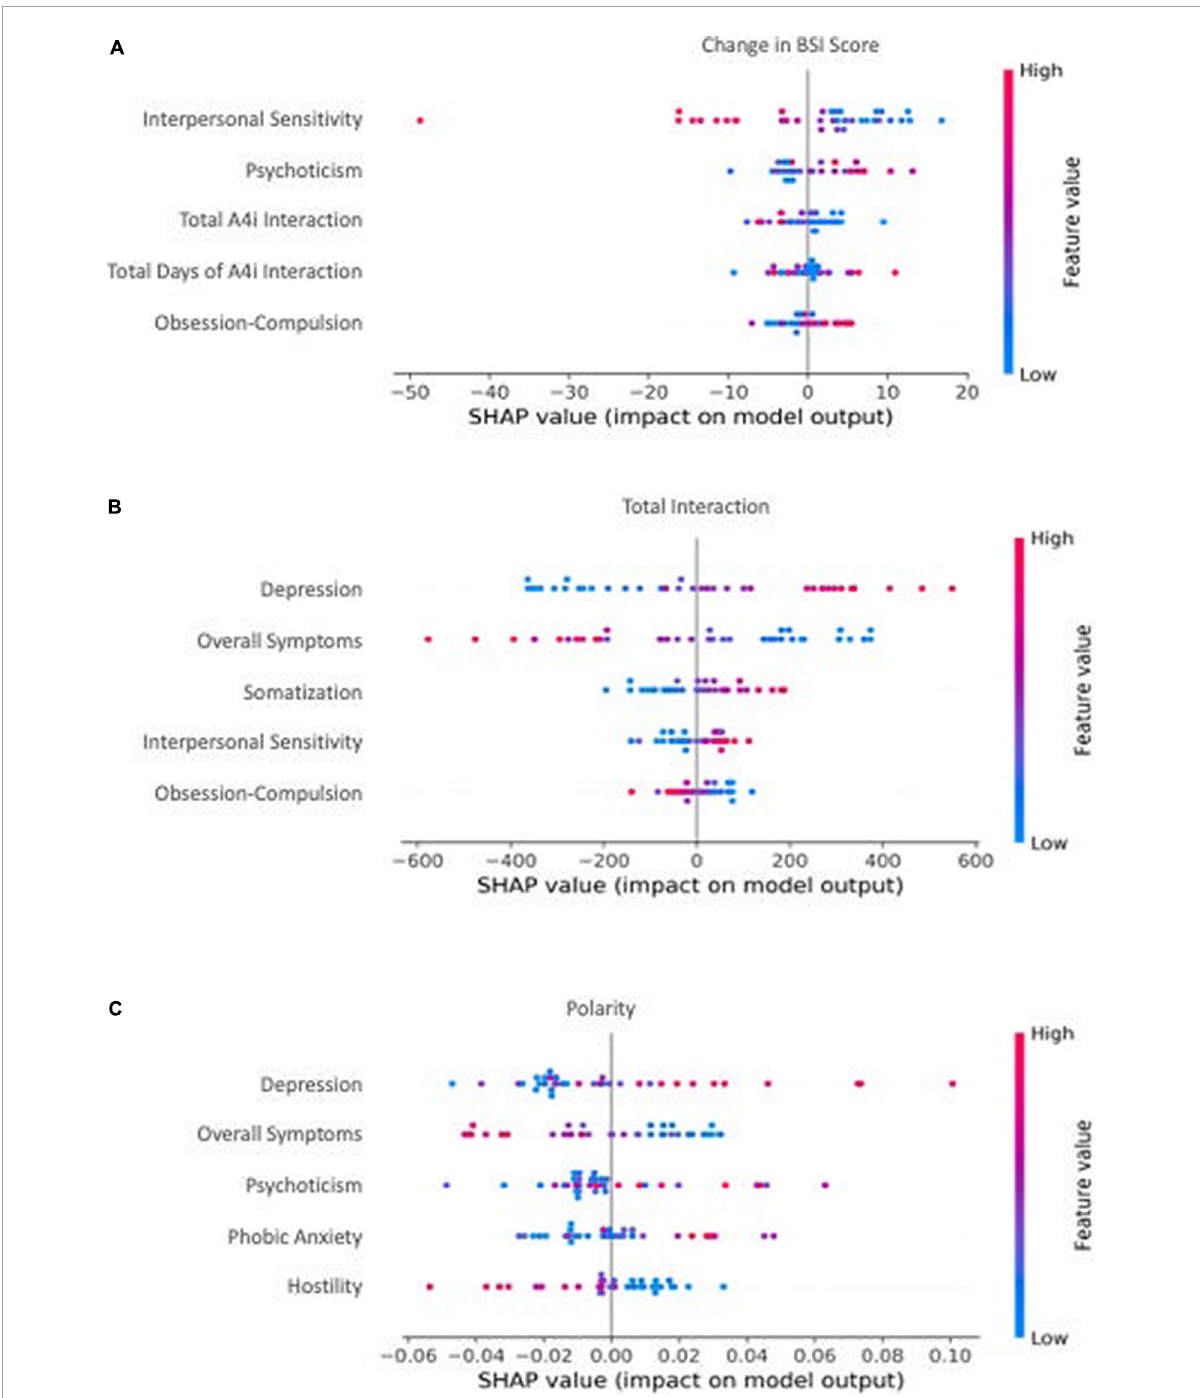
FIGURE2 The top 5 most influential features by model. Individual dot color corresponds to the value of the feature, and location on the x-axis corresponds to that point’s relative impact on the model output [e.g., a high-feature value (red) with a corresponding high x-axis value (SHAP value) represents a point that strongly, positively influences the model’s outcome prediction]. (A) The most influential features from baseline BSI total score, subcategory scores, and passively collected A4i use metrics for predicting change in BSI total score. A positive x-axis value (SHAP value) corresponds to an increase in overall symptoms. (B) The most influential features from baseline BSI total score and subcategory scores for predicting a participants’ overall interaction) with the A4i app. A positive x-axis value (SHAP value) corresponds to an increased interaction with A4i. (C) The most influential features from baseline BSI total score and subdomain scores for predicting an individual participant’s sentiment toward the intervention. A positive x-axis value (SHAP value) corresponds to an increase in qualitative A4i